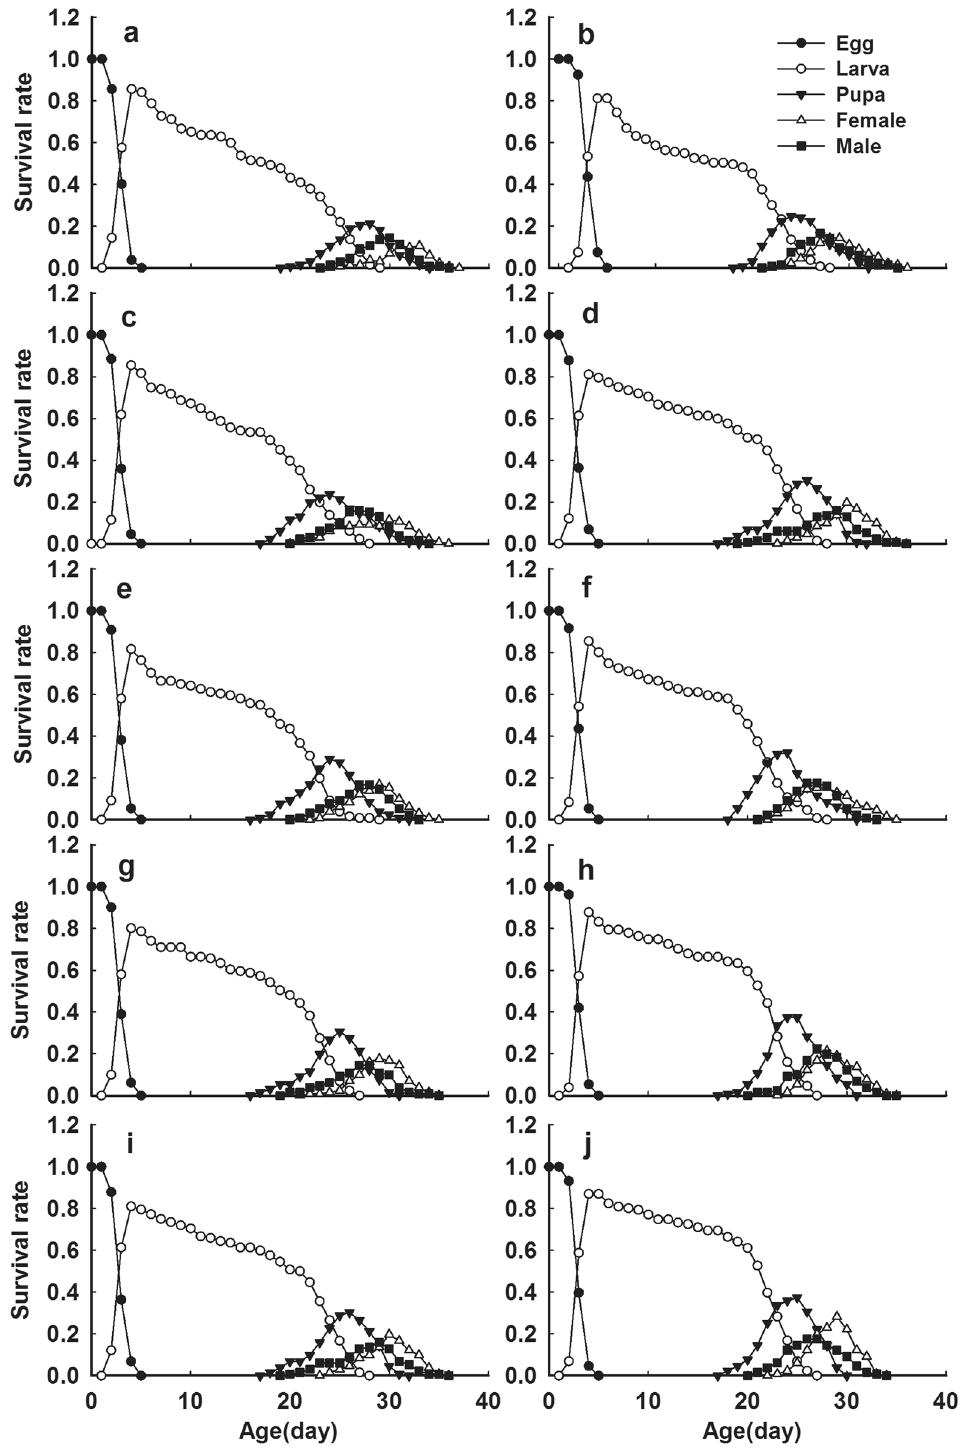
Figure 2. Age-stage-specific survival rate ( S xj ) of B. odoriphaga reared on different garlic cultivars, Qixian ( a ), Cangshan ( b ), Nanfang ( c ), Jinxiang ( d ), Zajiao ( e ), Sichuan ( f ), Xinxiang ( g ), Zhongmu ( h ), Yishui ( i ), and Siliuban ( j